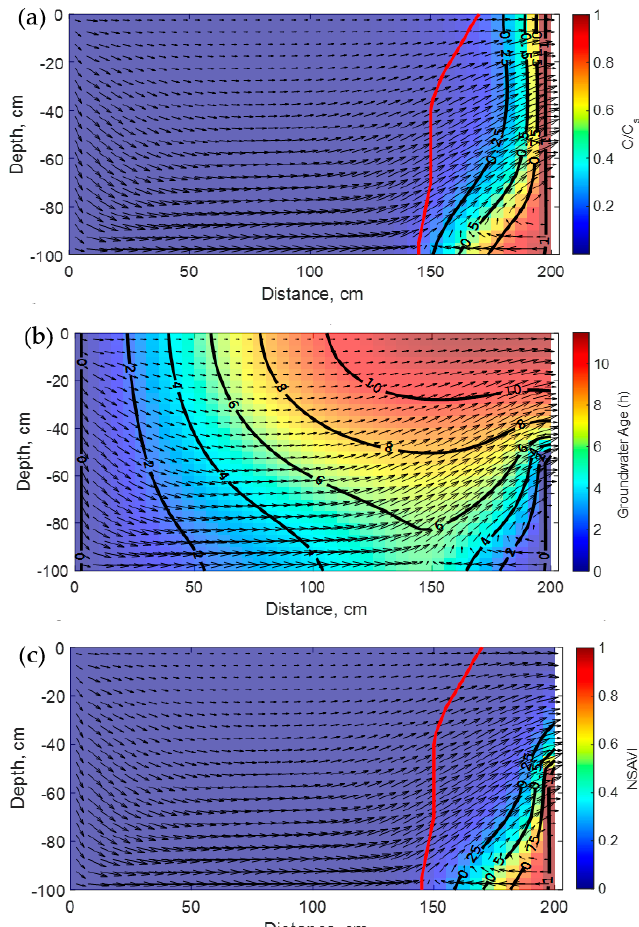
Figure 7. Spatial distribution patterns of ( a ) the steady-state concentration isochlors, ( b ) the direct mean groundwater age, and ( c ) the vulnerability index to seawater intrusion for the heterogeneous Henry problems with an exponentially increasing permeability with depth ( δ = − 3 ). The zero-vulnerability line (ZVL) is plotted with red color.